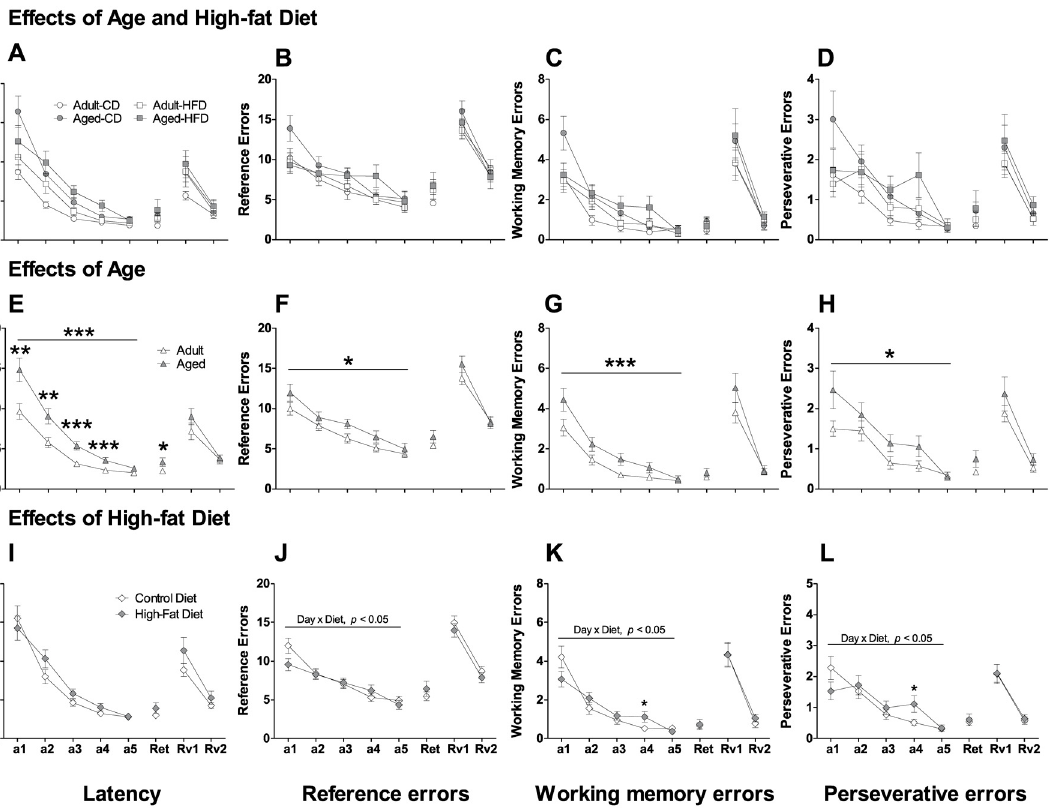
Fig 4. Effects of aging and exposure to high-fat diet on spatial cognition in the Barnes maze. Average latency ( A,E,I ), reference errors ( B,F,J ), working memory errors ( C,G,K ) and perseverative errors ( D,H,L ) by adult and aged mice on control diet (CD) and high-fat diet (HFD) on the Barnes maze acquisition days (a1-a5), retention day (Ret) and reversal learning days (Rv1-Rv2). In the top panels data for all groups are displayed whereas in the middle and bottom panels data are collapsed for age and diet, respectively. Aged mice performed worse than adult mice during the acquisition days as reflected by increases in latencies ( E ) and all errors (reference ( F ), working memory ( G ) and perseverative ( H )). Mice on HFD tended to make more errors on day 4 of acquisition trials ( K,L ). The data are expressed as mean ± SEM. * p < 0.05, ** p < 0.01, *** p < 0.001.